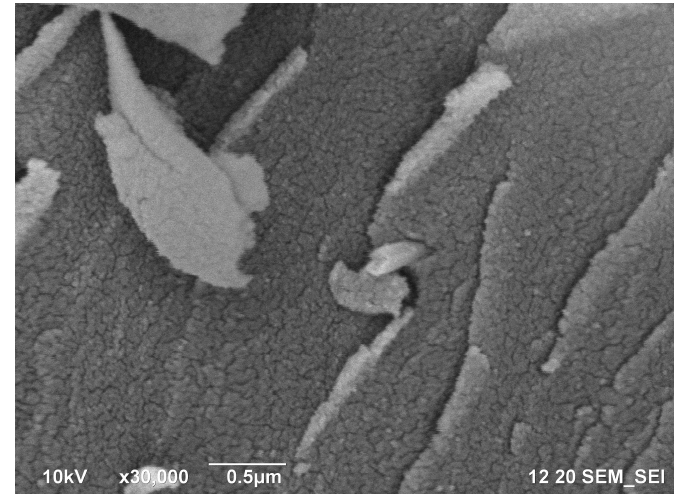
Figure A4. SEM micrograph of the silica gel with 0.05% halloysite cleaved in liquid nitrogen. The halloysite nanotube is visible in the center of the image. Scale bar, 500 nm.